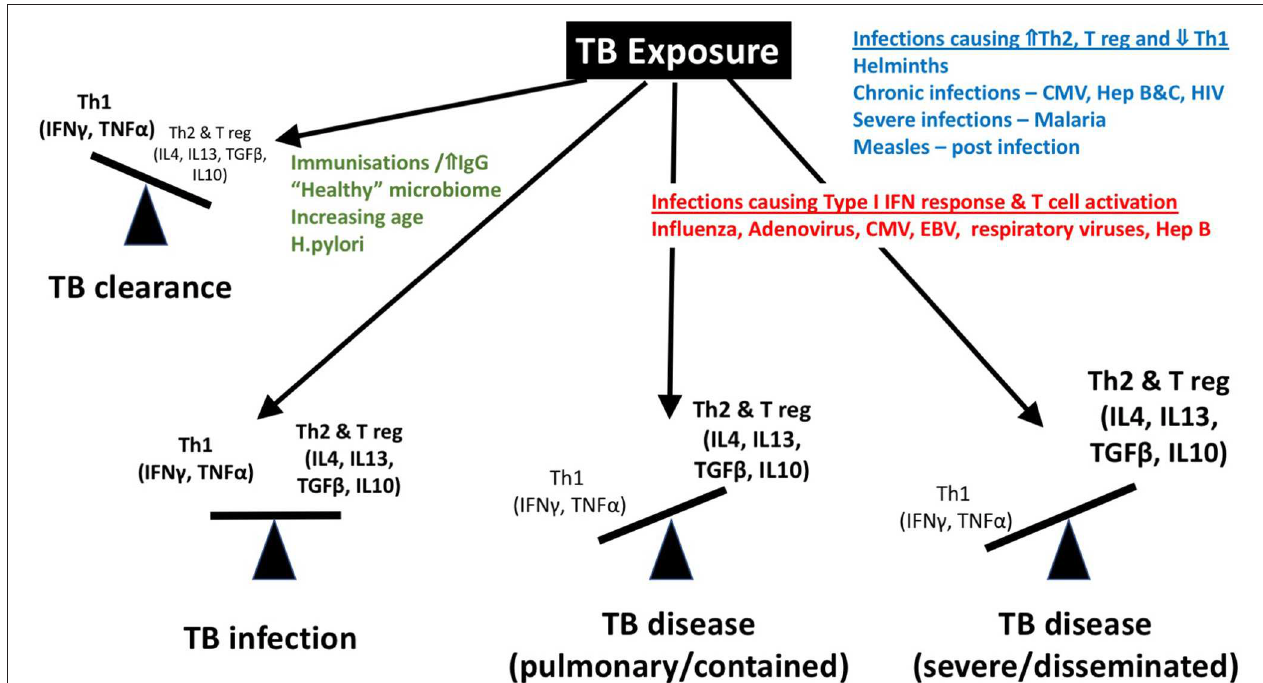
FIGURE 4 | Although a “protective immune response” to tuberculosis remains elusive, a Th1 predominant response is associated with protection, while a Th2 and regulatory T cell predominance has been described in association with severe disease and dissemination. We propose that the balance of these immune responses is influenced by co-infections including helminths, CMV, hepatitis viral infections, malaria, measles, etc. IFN, interferon; IgG, Immunoglobulin G; TNF, tumor necrosis factor; T reg, regulatory T cell; IL, interleukin; TGF, tumor growth factor; HIV, human immunodeficiency virus; CMV,